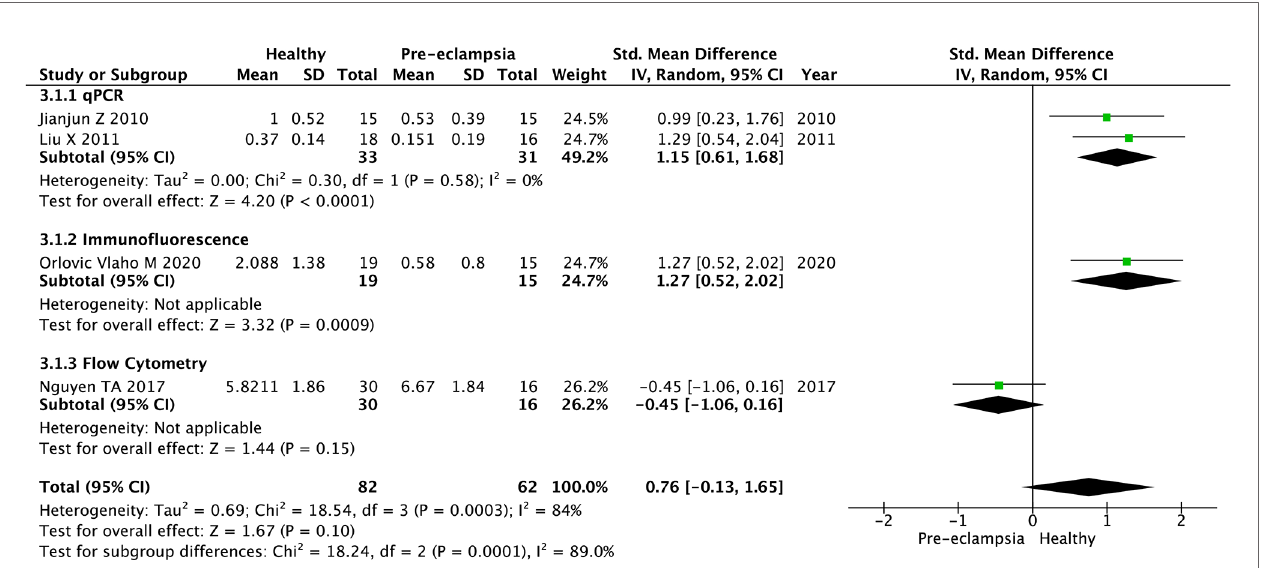
FIGURE 3 | Standardized mean difference of T regulatory cell numbers in the decidua of healthy pregnant women and women with pre-eclampsia. CI, con fi dence interval; SD, standard deviation; Std. Mean Difference, standardised mean difference; IV, inverse